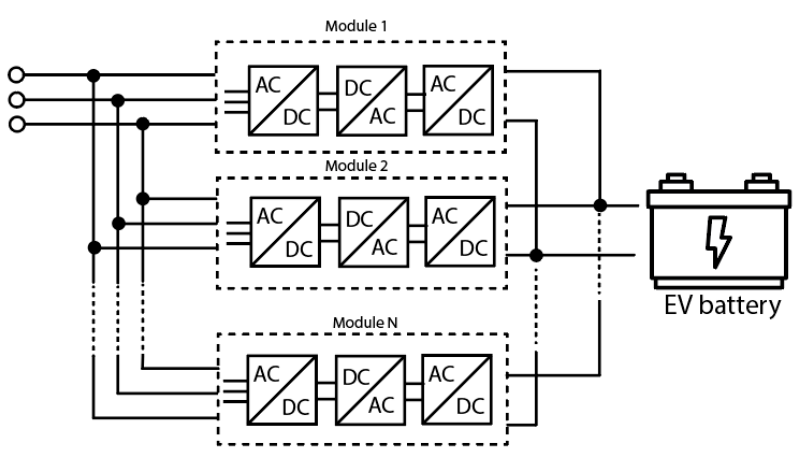
Figure 2. Electric scheme of IPOP architecture.